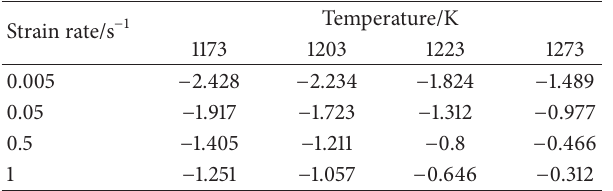
Table 3: The value of ln [ sinh (𝛼𝜎)] at different deformation condi- tions of